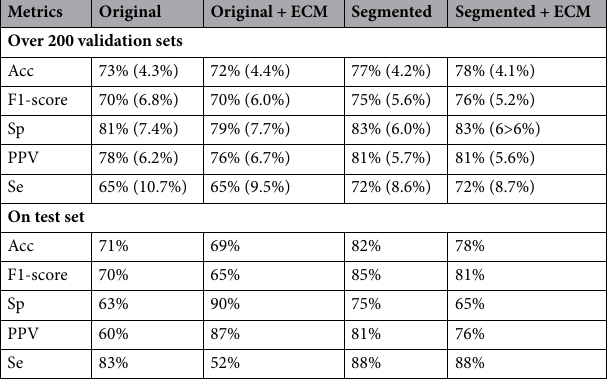
Table 3. Metrics achieved according to pre-processing. Over 200 validation sets the percentage represents the mean metric over the 200 validation sets with the standard deviation in parenthesis. On test set the percentage represents the metric on the test set with the voting ensemble method.